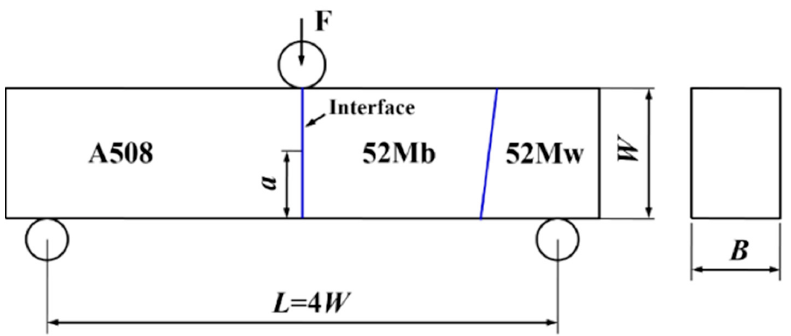
Figure 3. The geometry and loading configuration of the singe edge notched bend (SENB) specimen.